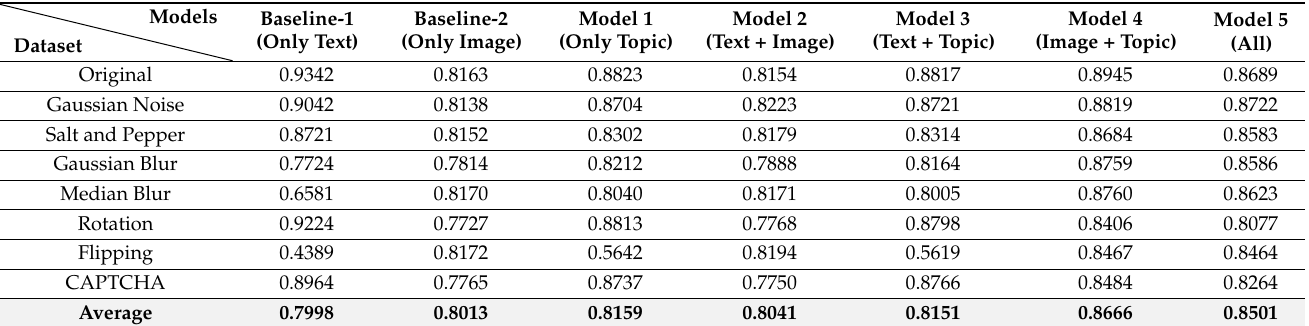
Table 15. Performance of spam image classification model with the Dredze